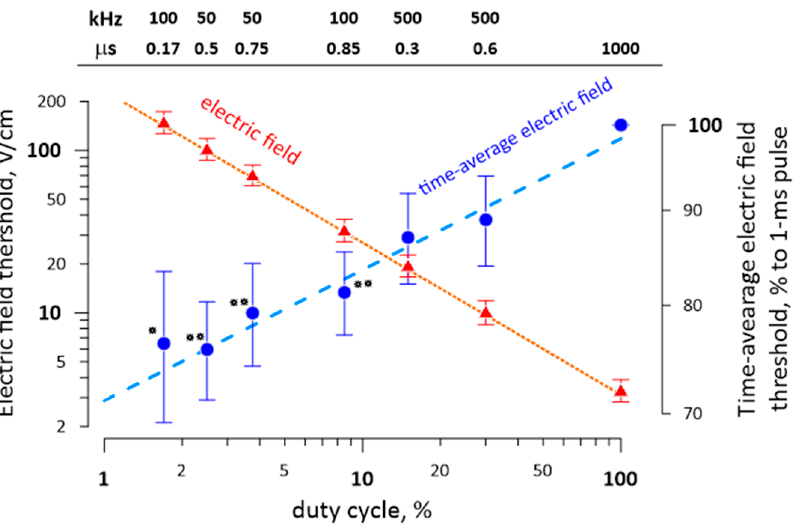
Figure 6. The electric field threshold for diverse 1-ms nsPEF bursts is determined by the duty cycle irrespective of the specific pulse duration or repetition rate (shown above each datapoint in µs and kHz, respectively). The “1000 µs” label is for a single 1-ms pulse. The blue symbols and the right vertical scale are for the electric field threshold averaged over the burst duration (1 ms) and normalized to the threshold for a single 1-ms pulse in the same nerve. Mean ± SE, n = 5. The time-average electric field threshold is significantly different from the threshold for 1-ms pulses (* p < 0.05 and ** p < 0.01, one-sample t -test). See the text for more details.